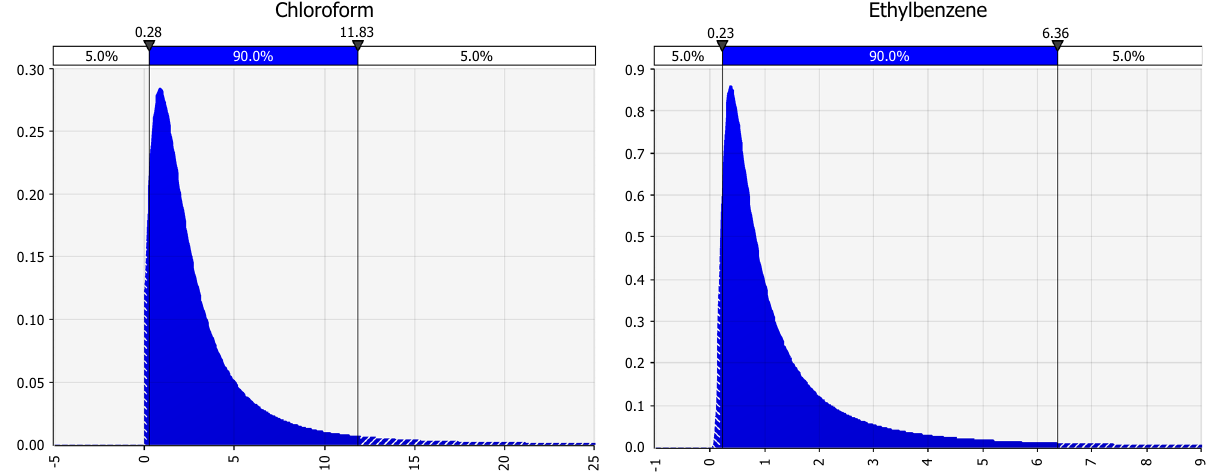
Figure 1. Fitted distributions of indoor air VOC data for two representative compounds, chloroform and ethylbenzene using @Risk. For both compounds, the graphs represent the respective probability density functions, the x-axis represents the airborne concentration (µg/m 3 ) of the VOC, and the y-axis represents the probability density. The indoor air data for chloroform were best fit by a log-logistic distribution, and the indoor air data for ethylbenzene were best fit by a Pearson5 distribution.